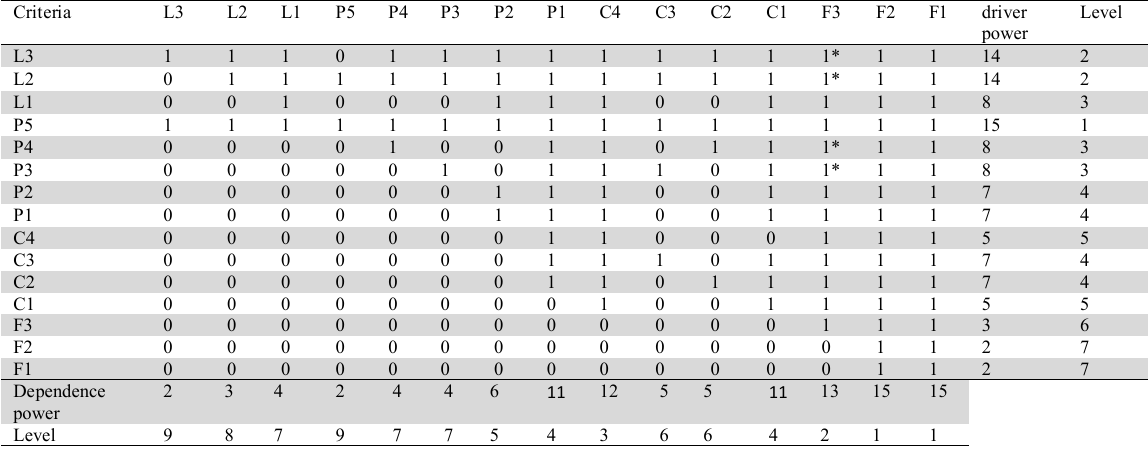
The reachability matrix for research